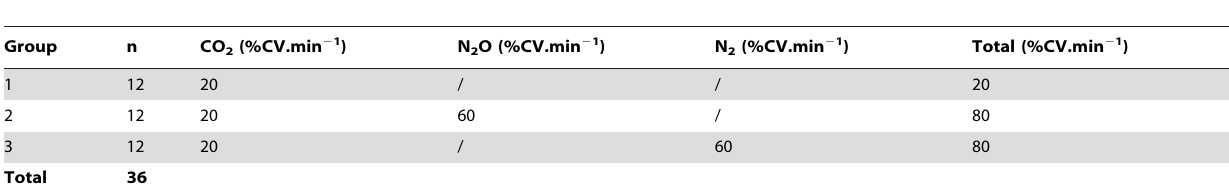
Table 3. Composition and flow rates of the gas mixtures used for mice euthanasia- main study.